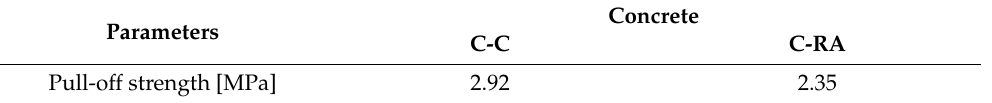
Table 11. Change in the average pull-off strength of concretes of the C-C and C-RA series.